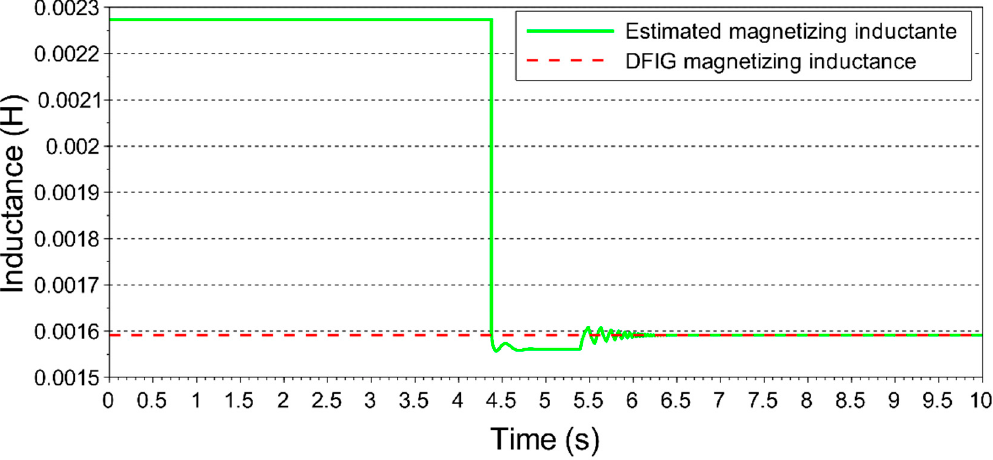
Energies 2020 , 13 , 770 Figure 14. Correcting magnetizing inductance. Figure 14. Correcting magnetizing inductance.